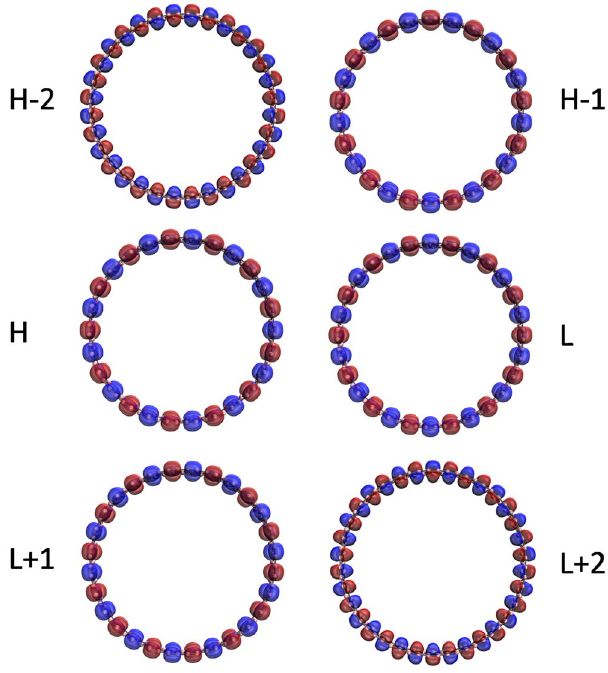
Figure 12. Visualization of the HOMO − 2 (1.614), HOMO − 1 (1.468), HOMO (1.468), LUMO (0.498), LUMO + 1 (0.498), and LUMO + 2 (0.464) for the ground state of c -BNR[2,60], obtained from spin-restricted TAO-LDA, at isovalue = 0.02 e/Å 3 . The orbital occupation numbers are shown in parentheses. Here, for simplicity, HOMO and LUMO are referred to as H and L, respectively.